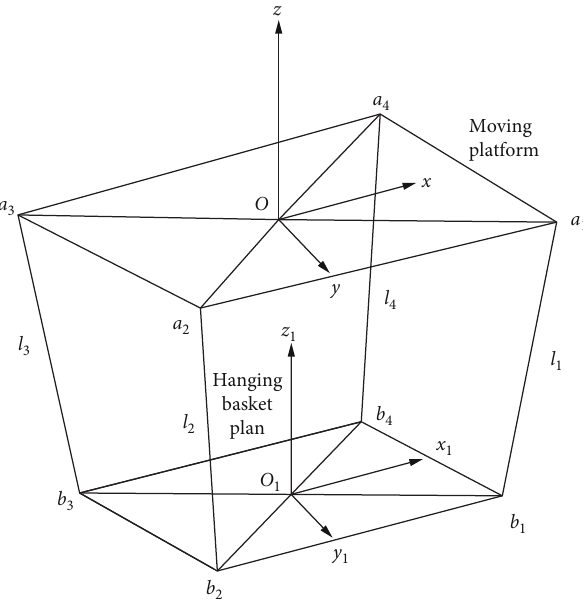
F IGURE 5: Schematic diagram of hanging